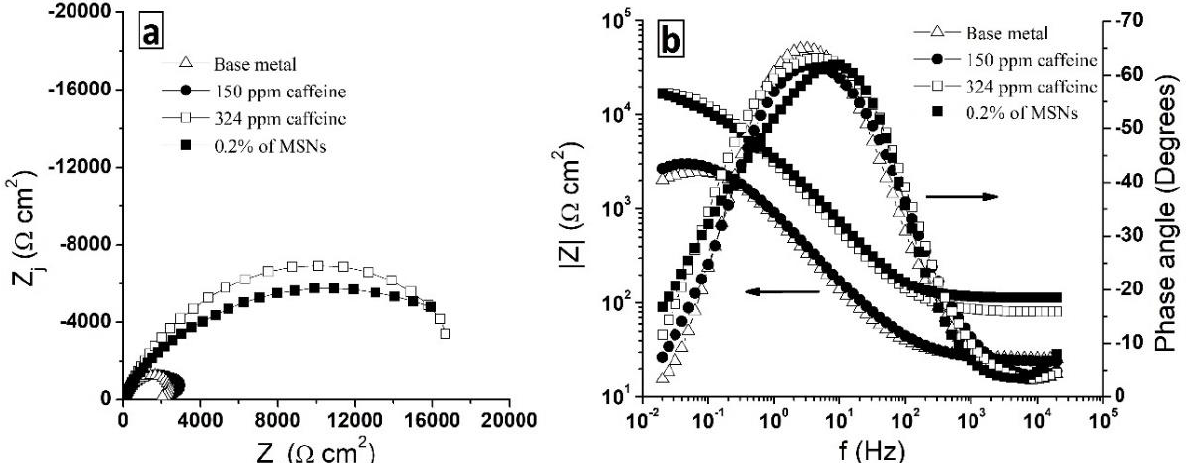
Figure 7. ( a ) Nyquist and ( b ) Bode plots (|Z|) and phase angle as a function of frequency for X60 steel immersed in pH 5 solution, 3.5% NaCl at 26 ◦ C, with 0 ppm, 150 ppm, and 324 ppm caffeine and with 0.2% MSNs w / v (the arrows indicate the corresponding axe for each curve).